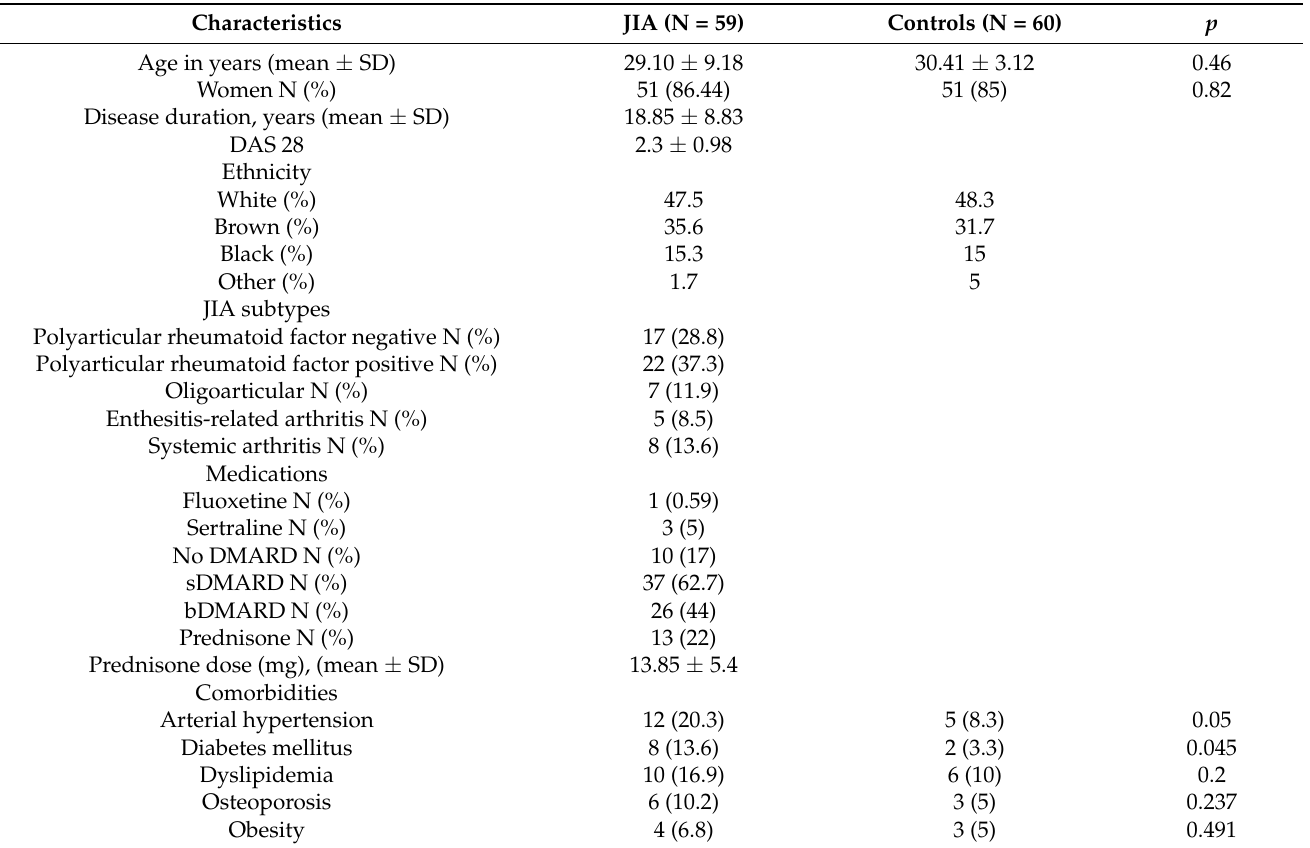
Table 1. Distribution of characteristics between